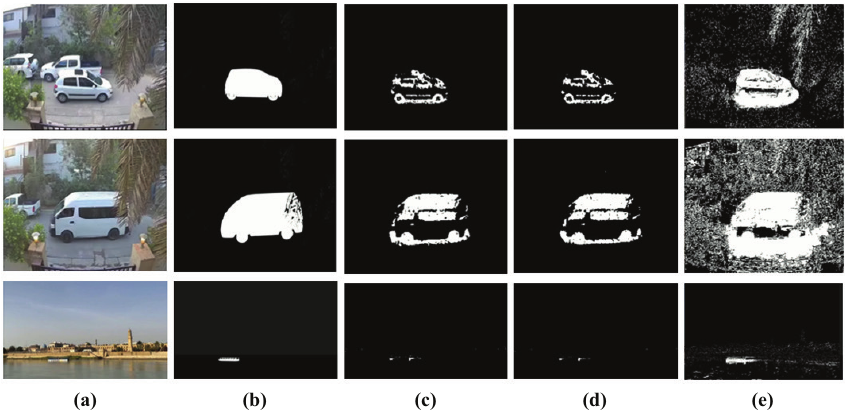
Fig. 9. Comparison of foreground detection results (a) original scenes (b) ground-truths (c) Fuzzy Choquet Integral subtraction (d) Fuzzy Sugeno Integral subtraction (e) Codebook